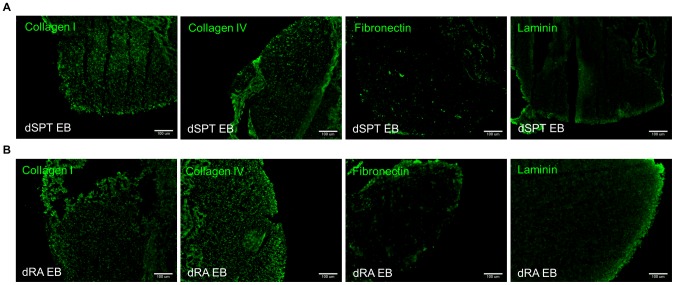
Immunofluorescence images of ECM biomolecules preserved after decellularization treatment in both groups of EBs.(A) dSPT EB and (B) dRA EB. Both groups of decellularized EB preserved Collagen I, Collagen IV, Fibronectin, and Laminin after decellularization treatment.